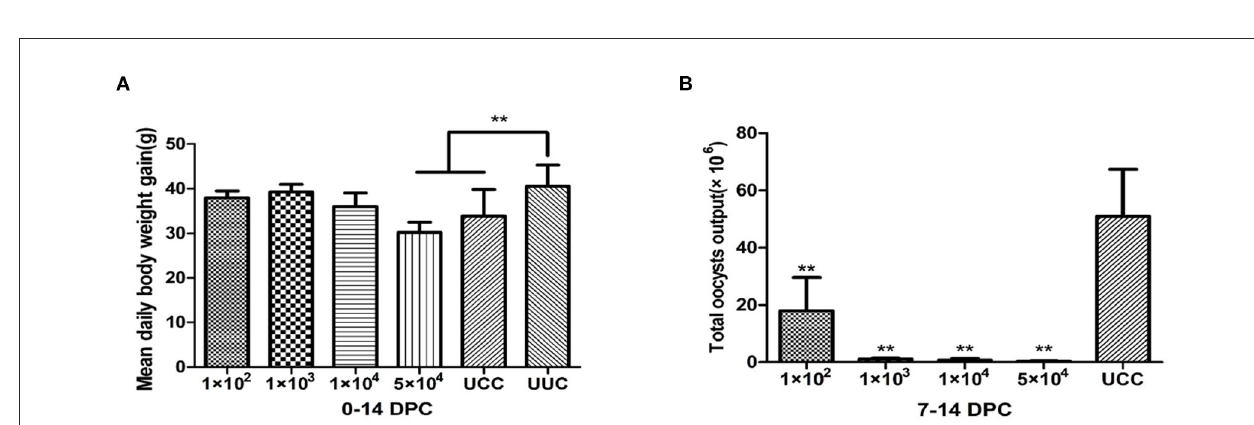
FIGURE2 Average daily weight gain of rabbits and total oocyst output in immunogenicity tests. (A) Average daily weight gain of rabbits 0–14 days after challenge. (B) Total oocyst output 7–14 days after challenge with 1 × 10 4 sporulated oocysts. DPC, day post challenge; UCC, unimmunized, challenged control group; UUC, unimmunized, unchallenged control group. ** P < 0.01 (Student’s t